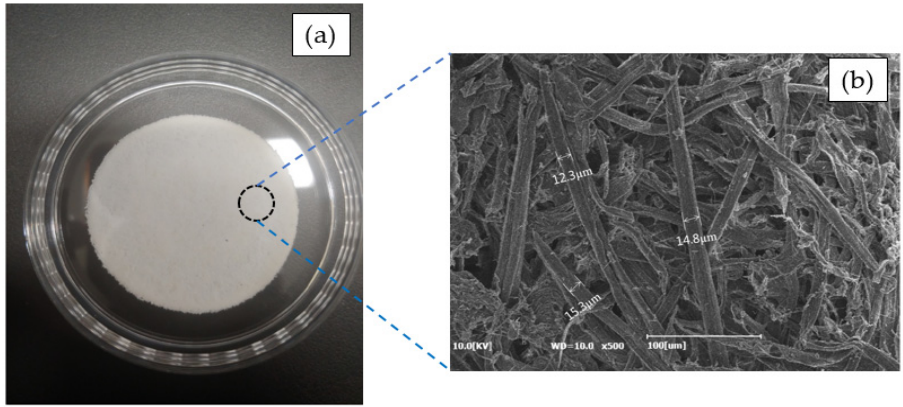
Figure 8. ( a ) Photographs and ( b ) SEM image of the bleached rice husk paper.